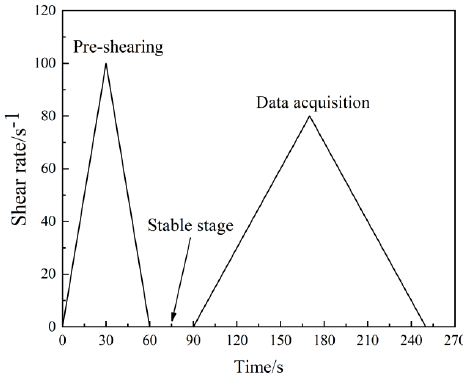
Figure 3. Test procedures of the rheological instrument.